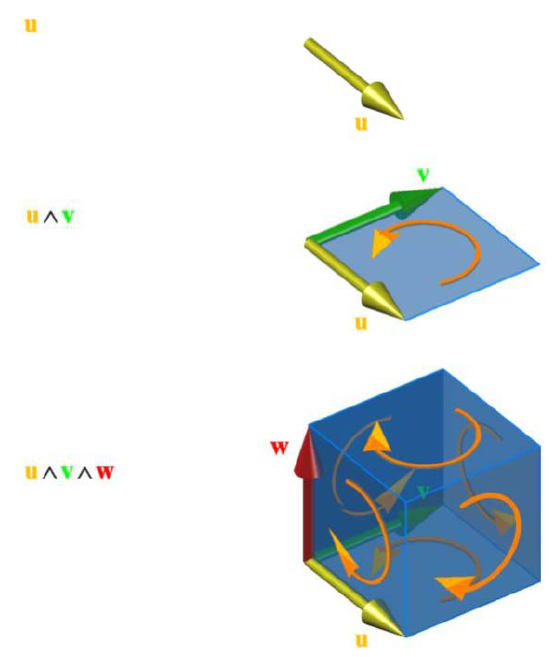
Figure 13: Geometric interpretation for the exterior product of p vectors to obtain an p -vector (parallelotope elements), where p = 1, 2, 3 . The “circulations” show the inner